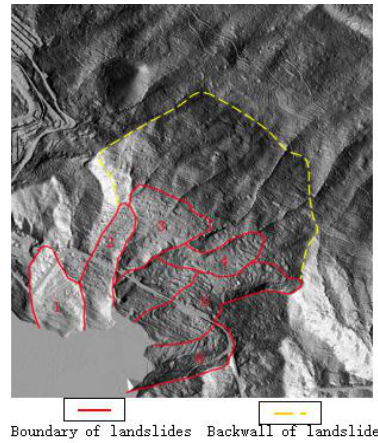
Fig.5 Boundary and back scarp of